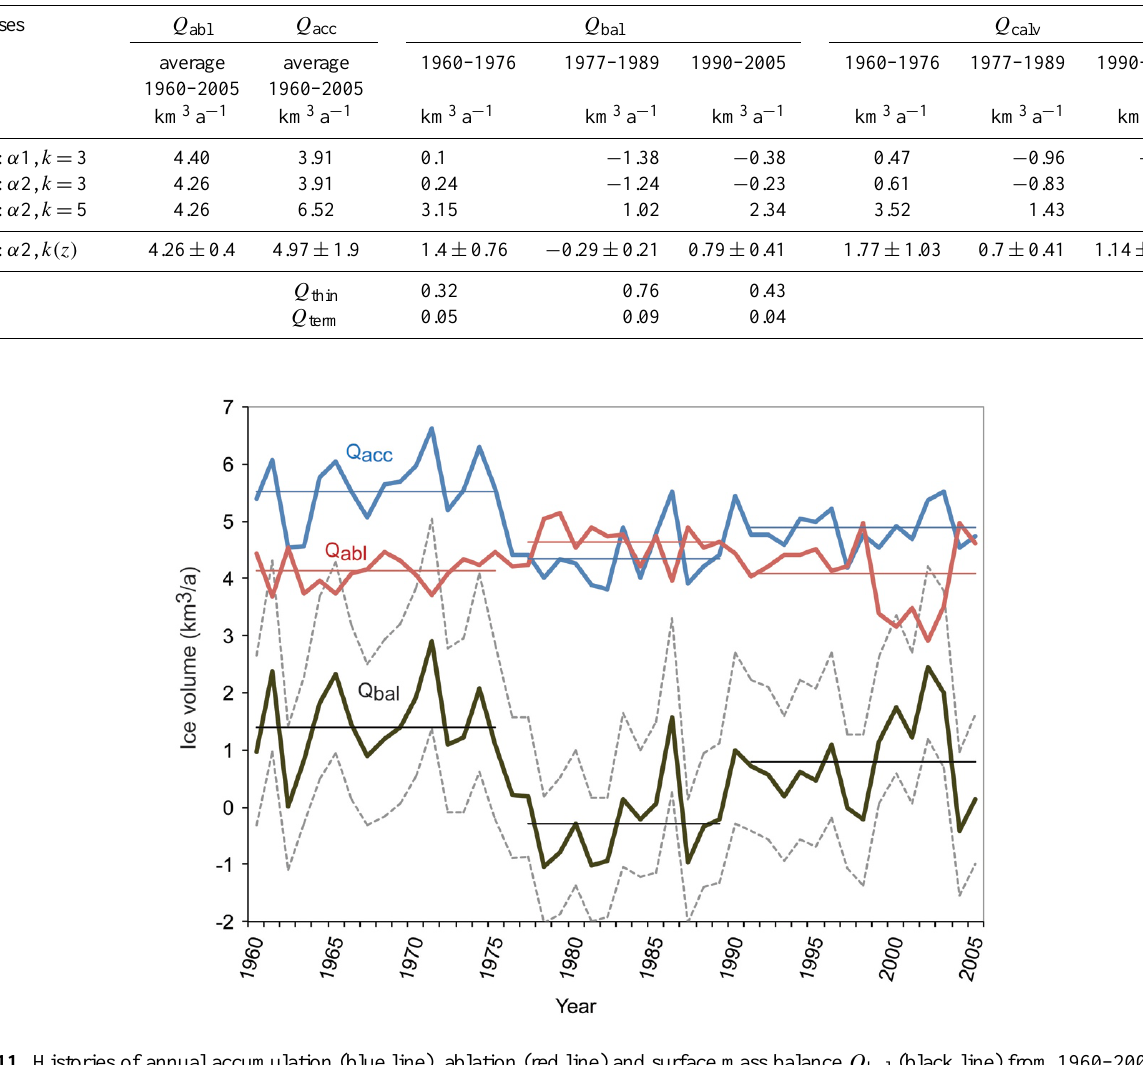
Fig. 11. Histories of annual accumulation (blue line), ablation (red line) and surface mass balance Q bal (black line) from 1960–2005. The three fluxes are derived from input scenario #4 (Table 2). The upper and lower ranges of surface mass balance fluxes Q bal , derived from the various inputs cases for accumulation fluxes Q acc and ablation fluxes Q abl listed in Table 2, are represented by dashed grey lines.